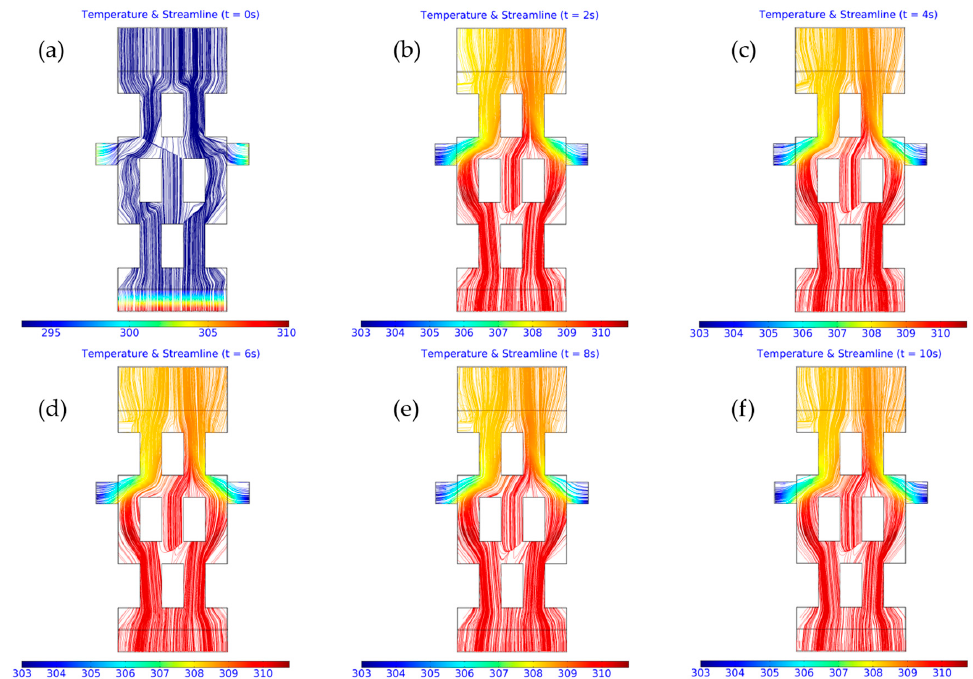
Figure 11. Average temperature of mixture over outlet nozzle domain (shown in blue) for mixing chambers with and without obstacles (Note: outlet nozzle domain is marked in blue).